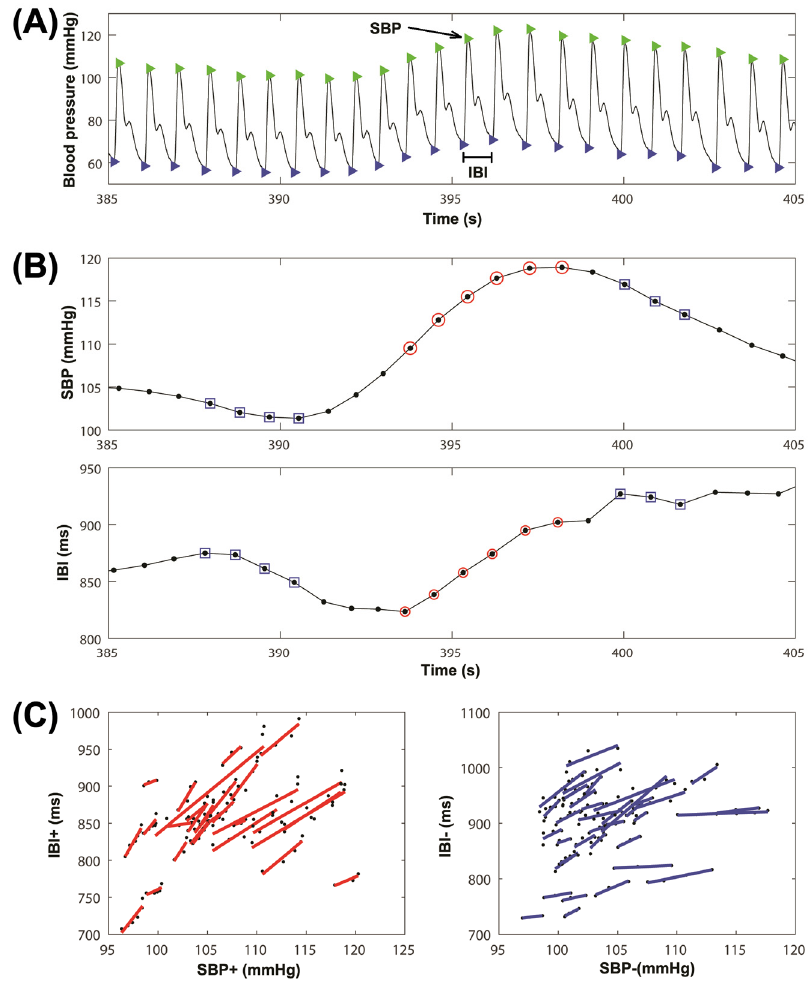
Figure 1. Example of blood pressure recording during supine position. ( A ) The beat identification and measurement of systolic blood pressure (SBP) and interbeat interval (IBI). ( B ) Identification of positive sequences (red circles) and negative sequences (blue squares), from filtered SBP and IBI signals. ( C ) Measurement of baroreflex sensitivity (BSR) from positive sequences (red lines in left panel with increasing SBP and IBI) and negative sequences (blue lines in right panel with decreasing SBP and IBI).